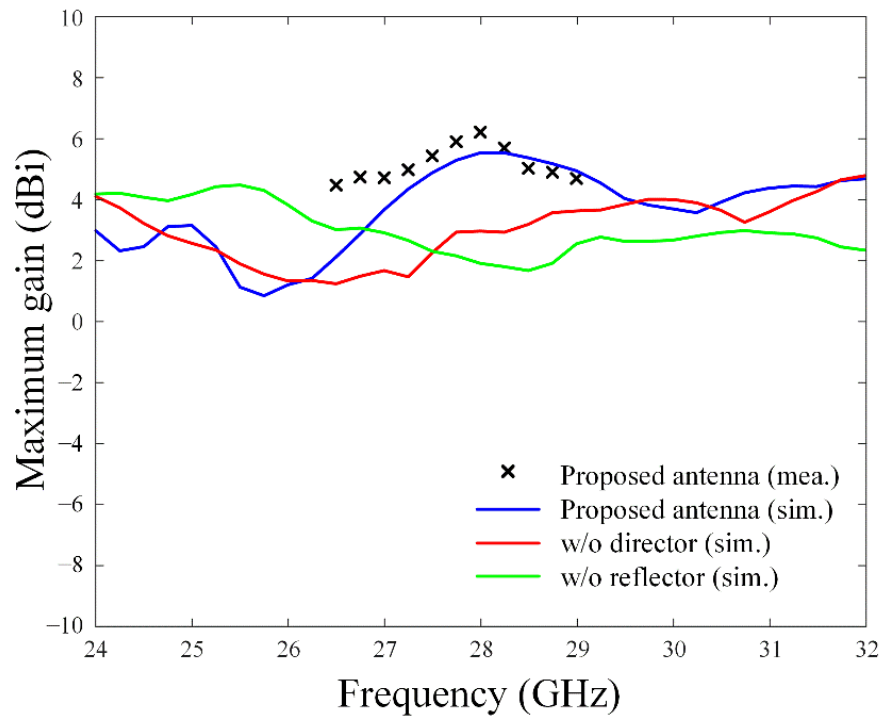
Figure 13. Maximum gains with and without the director and the reflector.